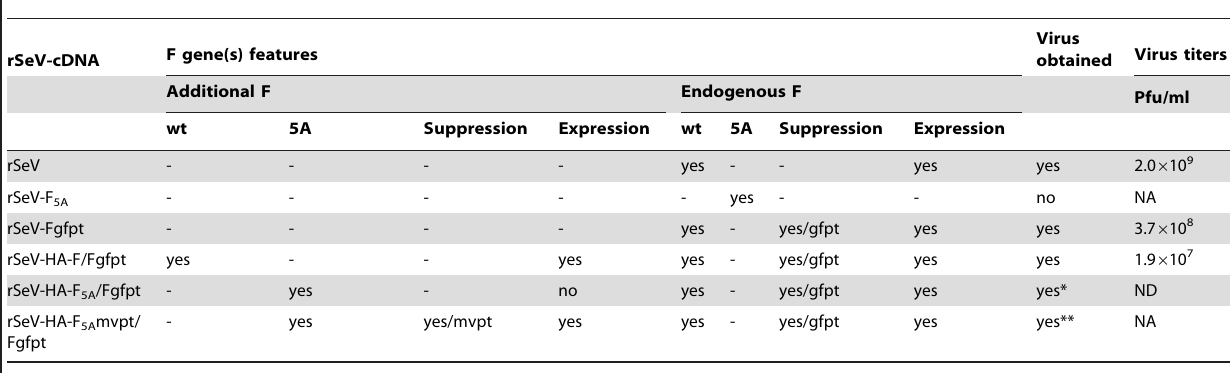
Table 1. Summary of recombinant virus